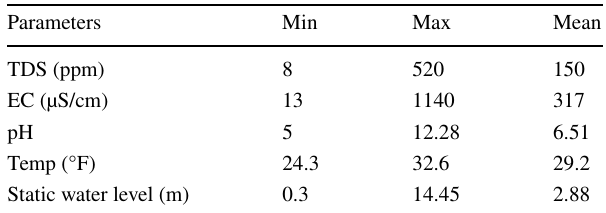
Table 1 Summary of estimated depths to saltwater Profile no.